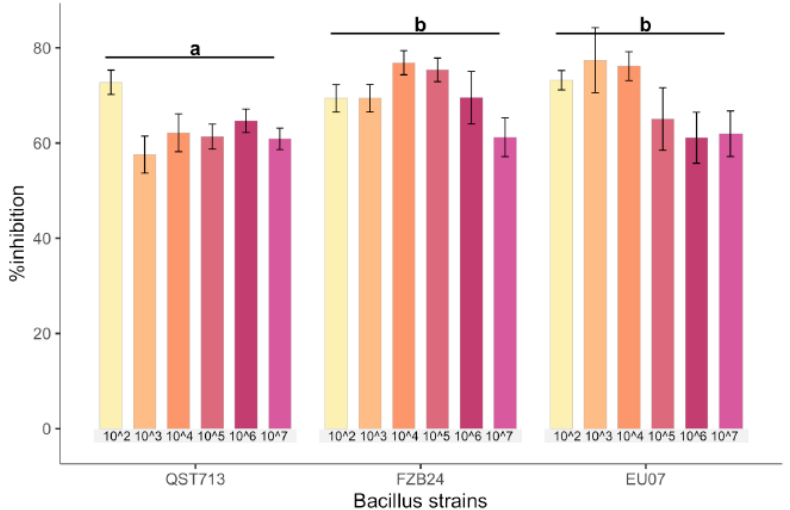
Figure 7. Growth of Bacillus strains in the presence of different DON concentrations. Bacillus strains (QST713, FZB24 and EU07) were grown in the presence of DON at different concentrations (0, 5, 15, 25, 50 and 70 ppm) in LB broth at 28 °C for 24 h at 200 rpm in 96-wells plates. Data were from one independent experiment with three replicates and shown as the mean ± SE. Experiments were repeated three times and similar results were obtained. Bar clusters with different letters were significantly different according to Tukey’s Test (α < 0.05) following two-way ANOVA. n = 72.